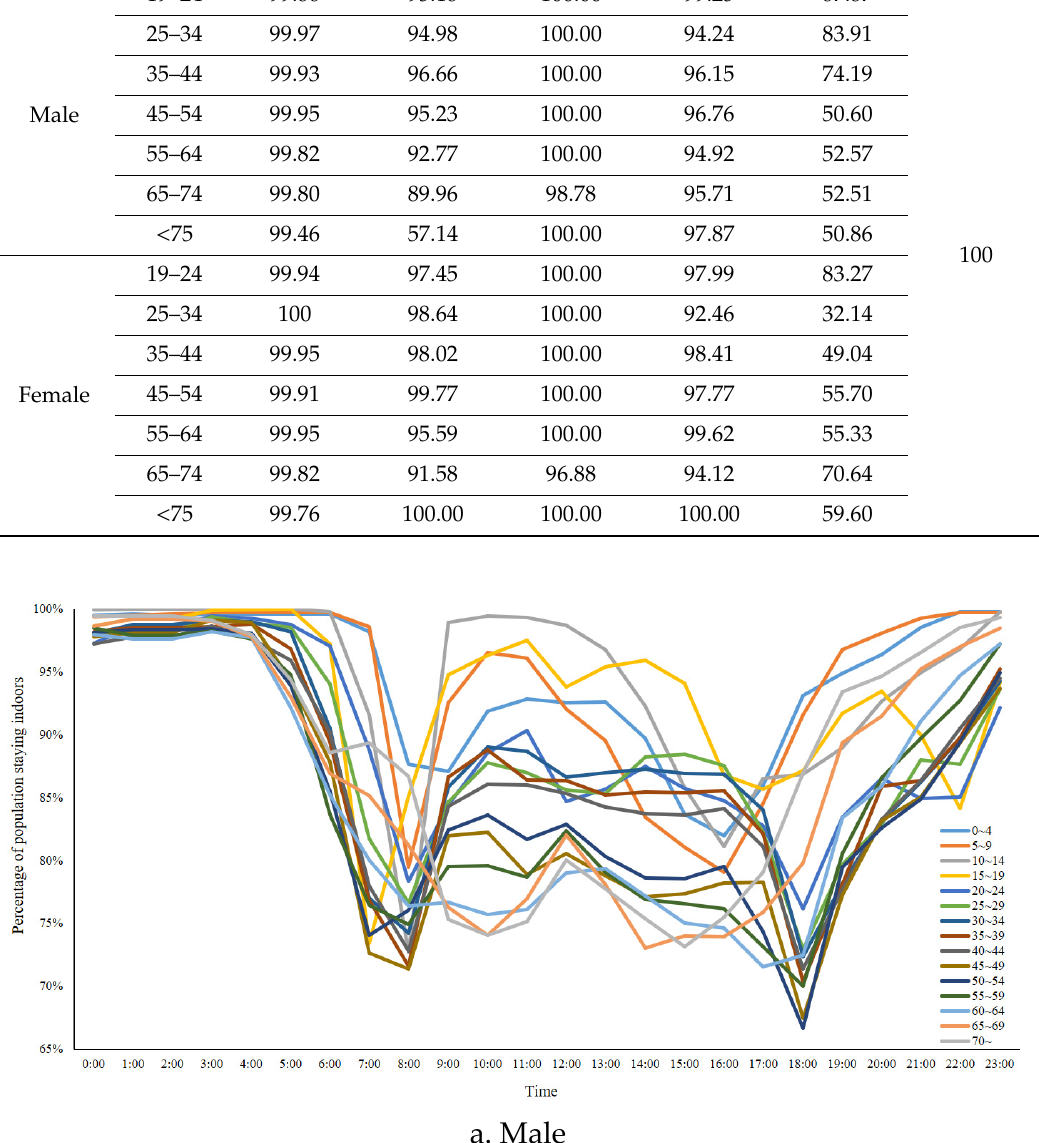
Figure 3. Percentage of population staying indoors by sex, age, and the time of the day in weekday. ( a ) Male ( b ) Female 2.4.Population Exposure We assessed the population exposure using PM 2.5 concentrations and the population distribution of each grid. The assessment of exposure was performed using the equation below (Equation 2). To map the outdoor PM 2.5 concentration, population distribution, and population exposure, we used Quantum GIS software version 3.16. Population Exposure = c i p i + c o p o (2) where c i is the indoor exposure concentration, c o is the outdoor exposure concentration, p i is the number of people indoors, and p o is the number of people outdoors. To assess the exposure to PM 2.5 of the entire population of Guro-gu, we calculated the PWAC by weighting the number of people to the exposure concentration in each grid (Equation 3). To assess population exposure to PM 2.5 probabilistically, we calculated the rate with the use of frequency analysis and histogram. The resulting rate of exposure exceeded the Korean Atmospheric Environmental Standard. We excluded the grid with a PWAC of zero (resulted from zero population) in the frequency analysis.